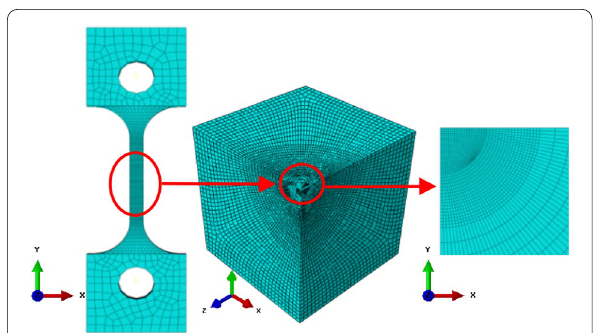
Figure 9 The mesh refinement